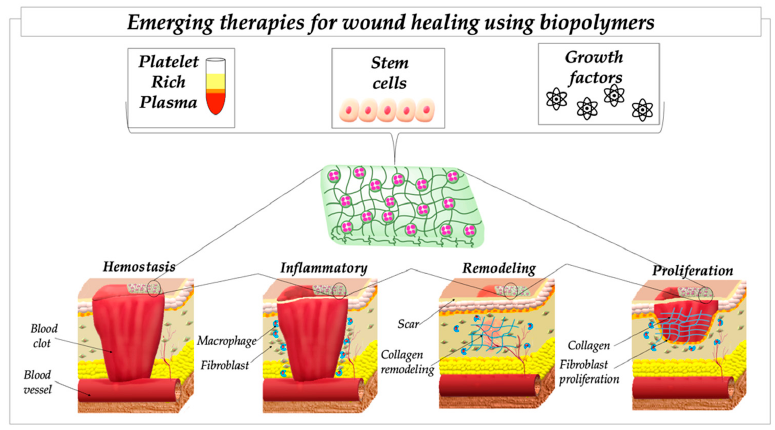
Figure 2. Emerging therapies for wound healing using biopolymers.